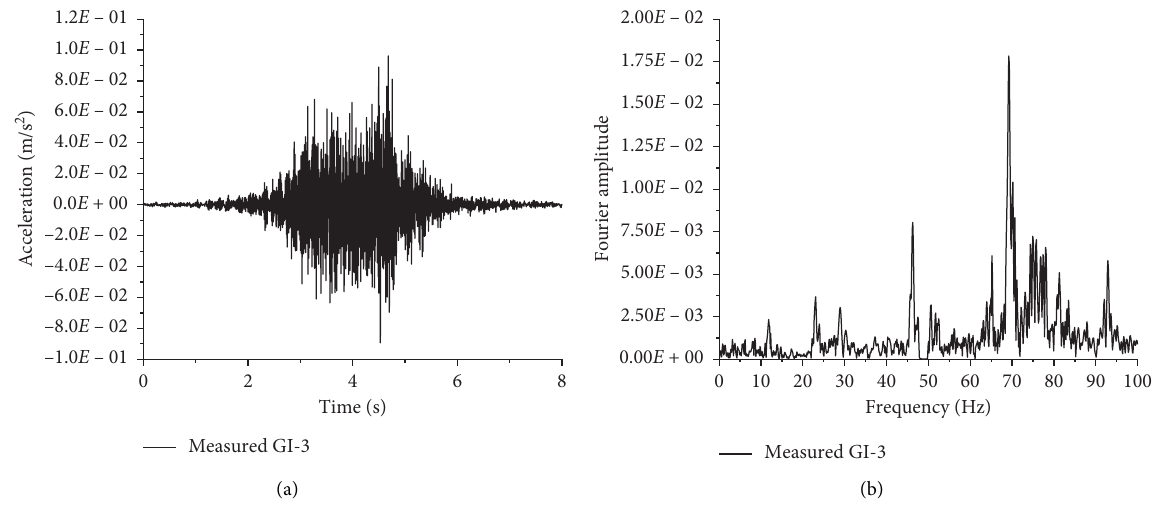
Figure 5: Acceleration: (a) time history and (b) frequency spectrum of GI-3.